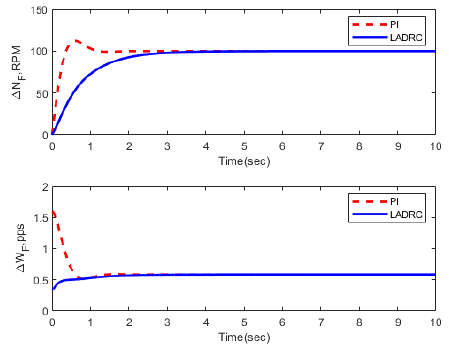
Figure 14. Step response of FC05.